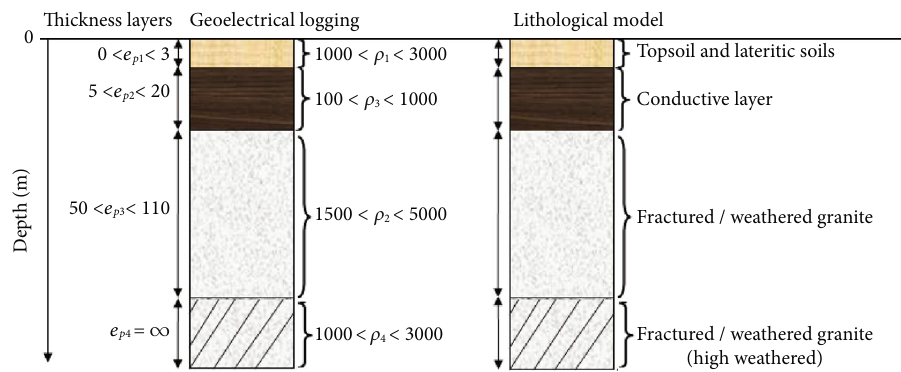
Figure 22: Lithological model of the sounding curves of type HK.